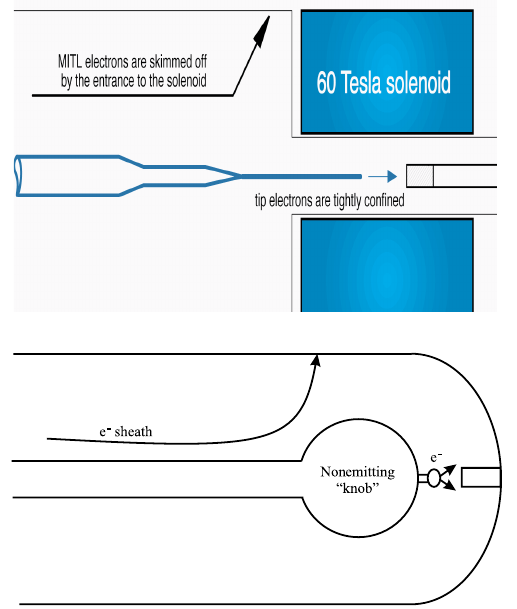
FIG. 18. (Color) Diodes on the end of MITLs. (a) Immersed B diode. (b) AWE paraxial